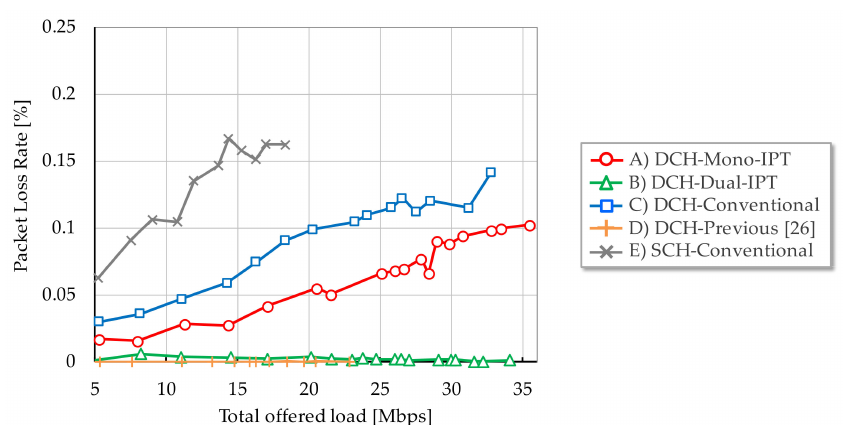
Figure 7. Average packet delay.